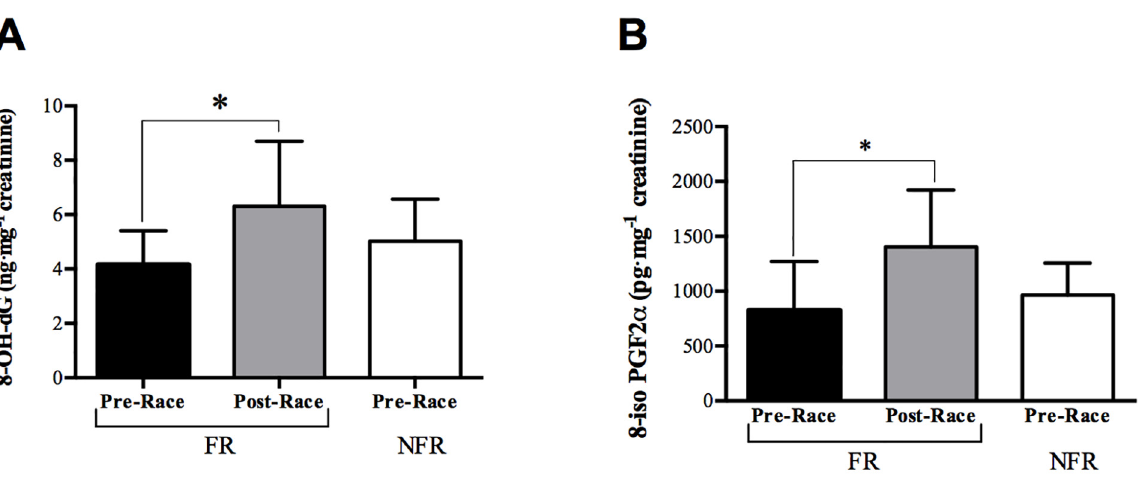
Fig 3. Effects of MUM on Oxidative damage biomarkers. Histograms of: A) 8-hydroxy-2-deoxy Guanosine (8-OH-dG, ng . mg -1 creatinine); B) 8-isoprostane (8-iso PGF2 α , pg . mg -1 creatinine) concentrations in the FR and NFR groups at Pre and Post-Race. Results are expressed as mean ± SD; * significant differences (P < 0.05) compared to Pre-Race.